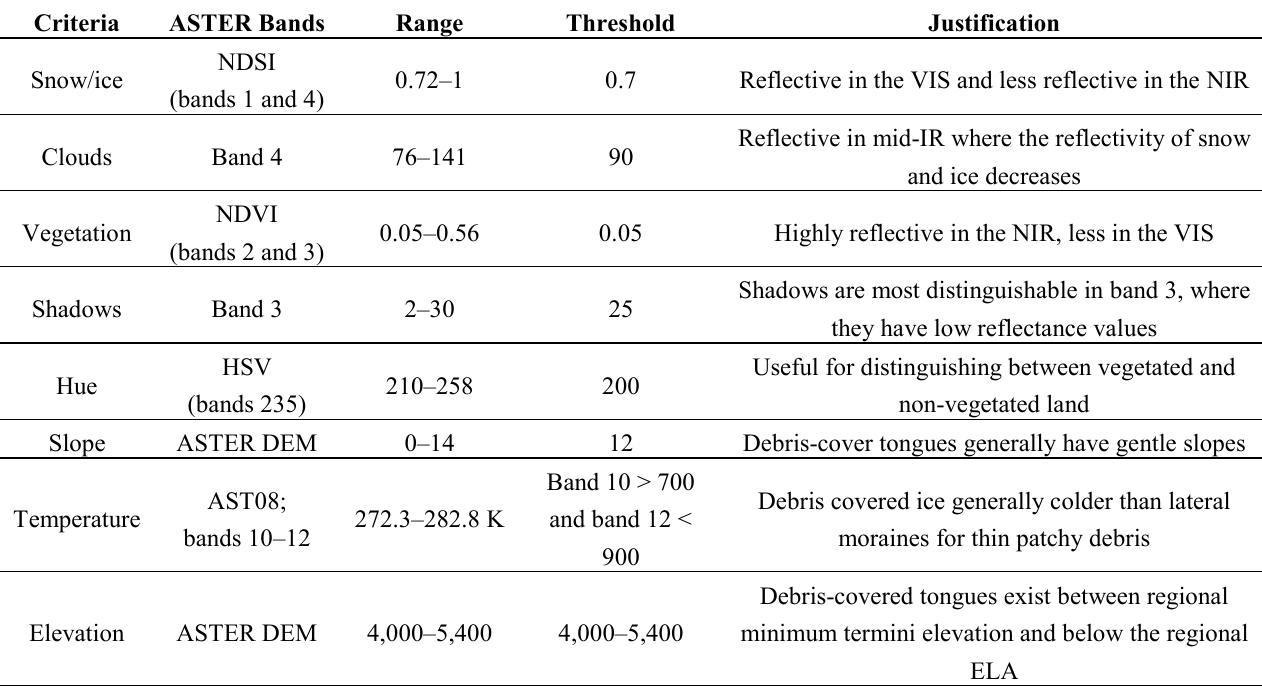
Table 2. Descriptive statistics and thresholds for each criteria used in the decision